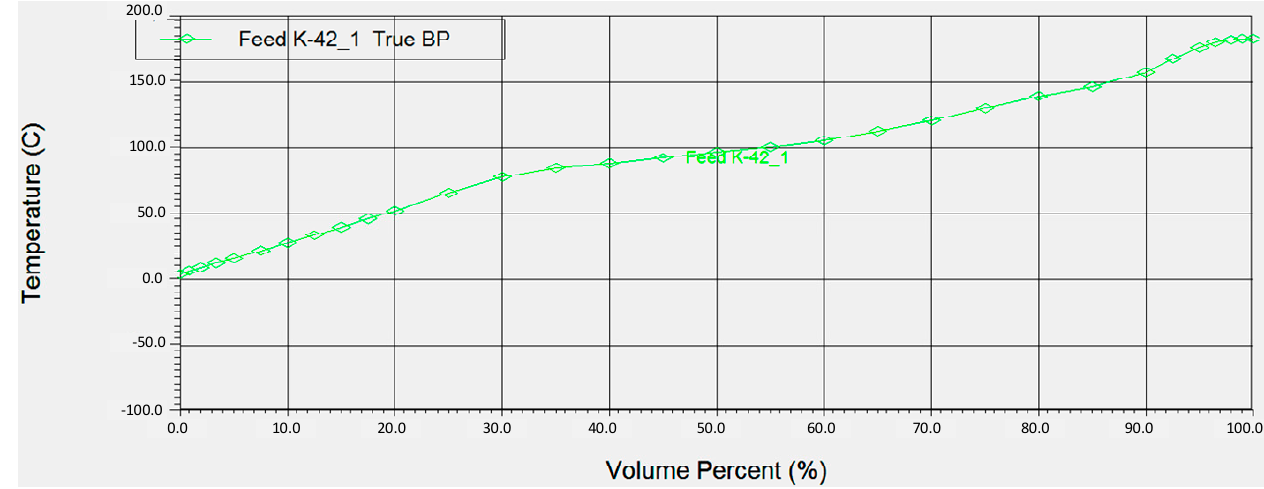
Figure A2. Feed K-42 TBP distillation blend.